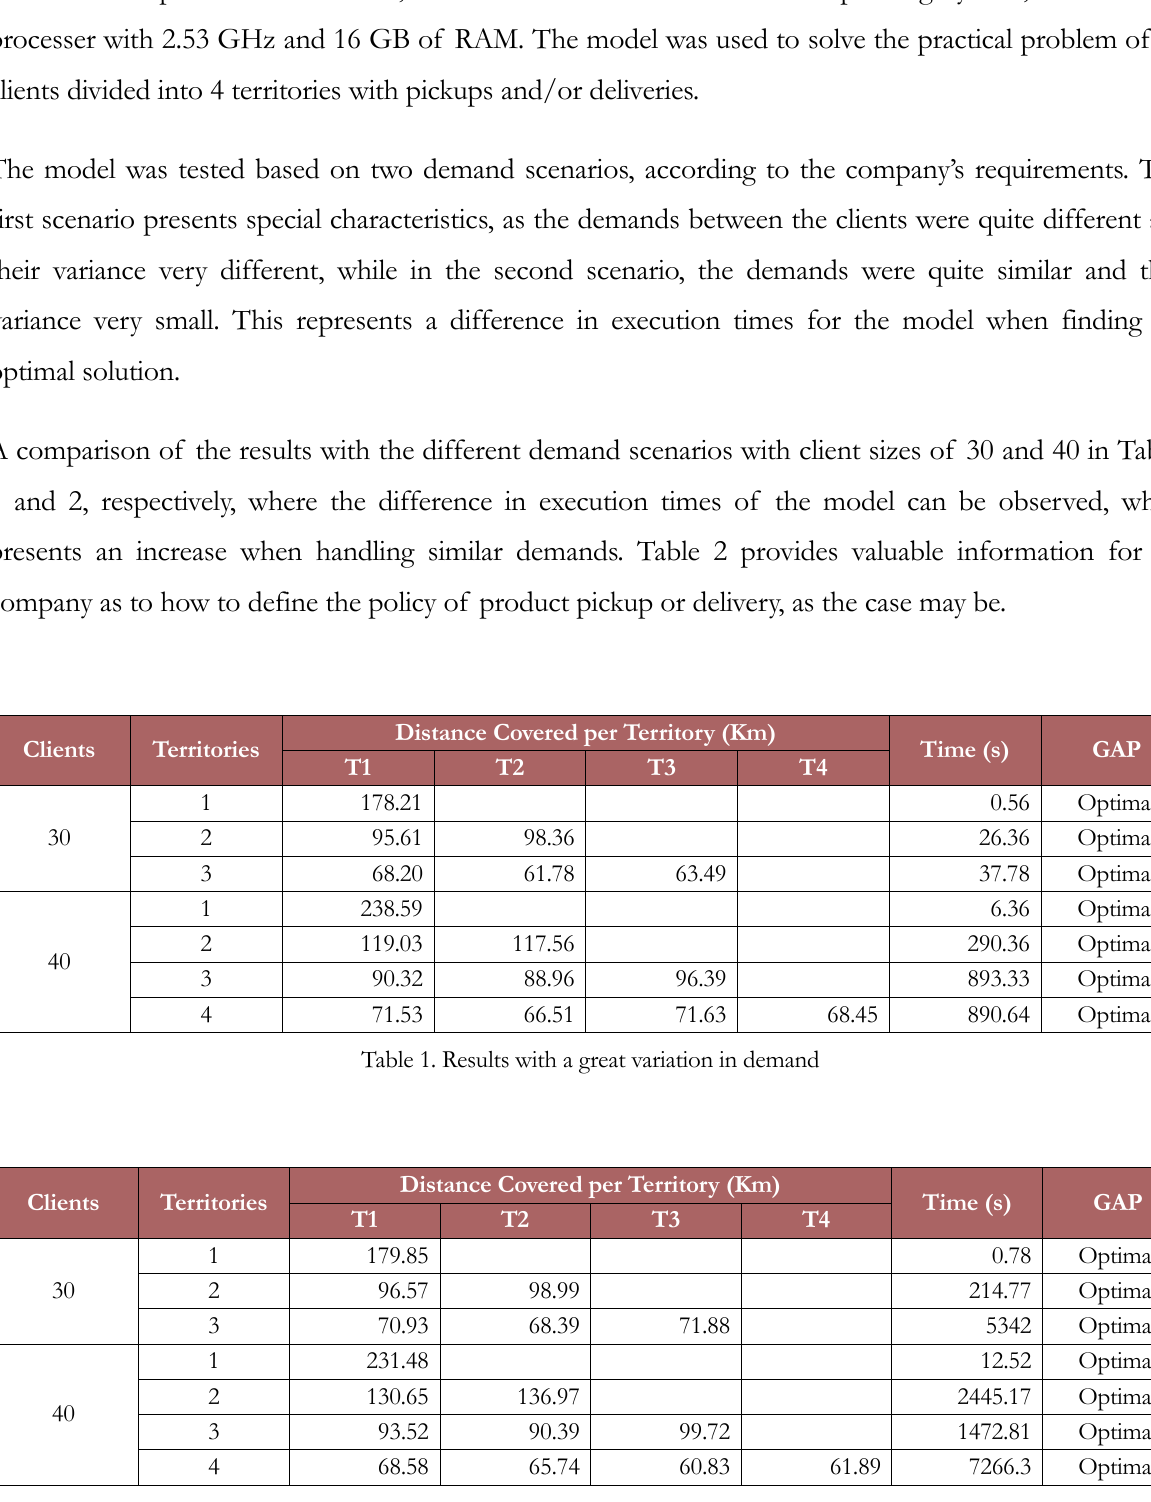
Table 2. Results with a small variation in